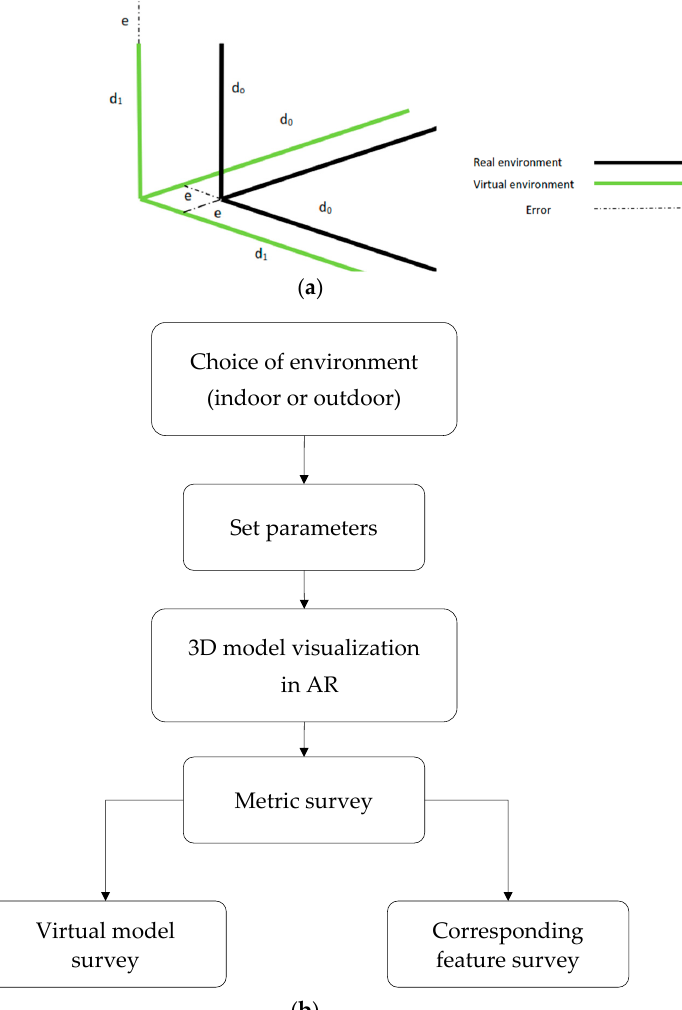
Figure 8. ( a ). Error of placement. ( b ). the adopted workflow of the experimental tests. Figure 8. ( a ) Error of placement. ( b ) The adopted workflow of the experimental The tests were performed in the same conditions (Table 1).